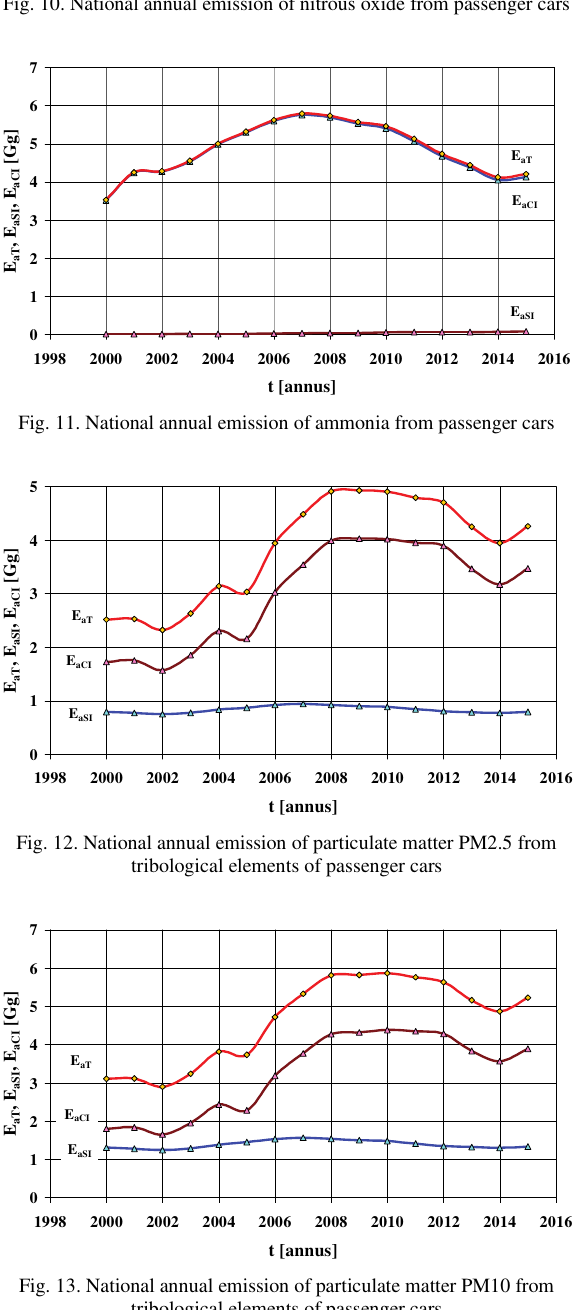
Fig. 17. Relative national annual emission of individual pollutants from a single passenger